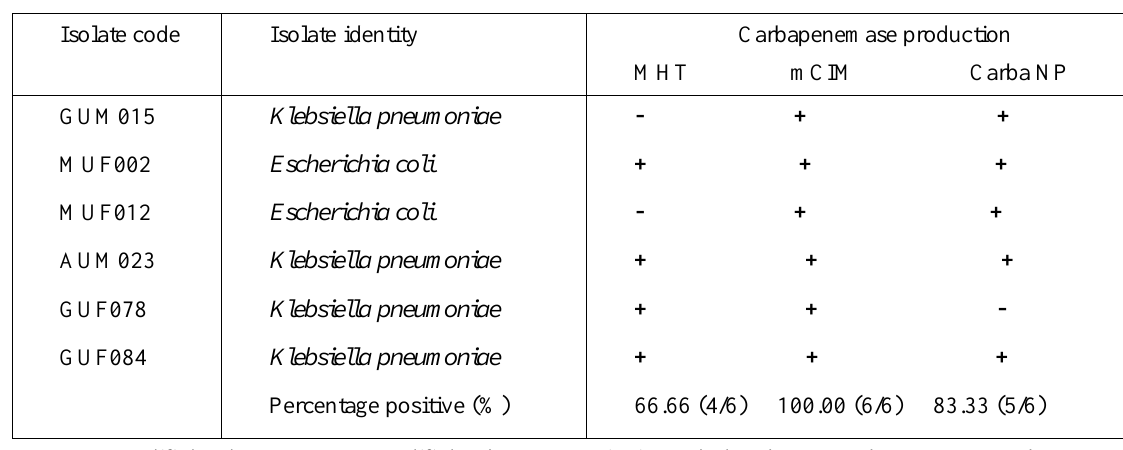
Table 1. Carbapenemase production using different detection techniques.